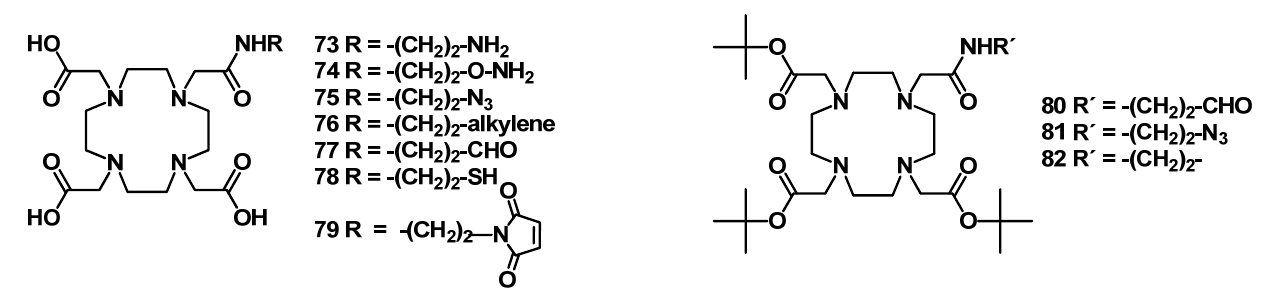
Figure 8. Chemical structures of DOTA-monoamide derivatives for the chemoselective conjugation to